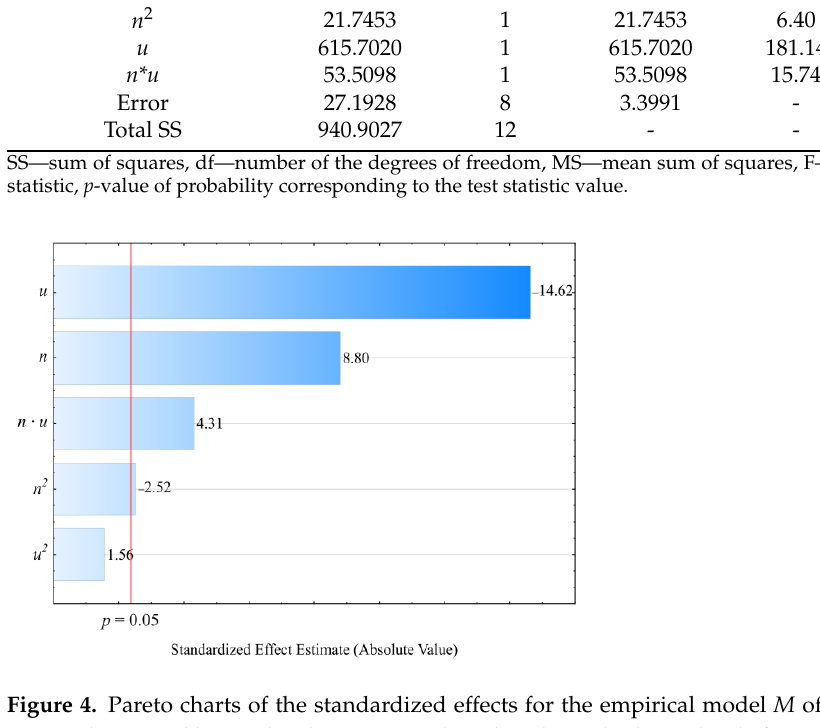
Table 3. Model of screw drive torque M—ANOVA table, R 2 = 0.97; R adj2 = 0.96. Source of Variation SS df MS